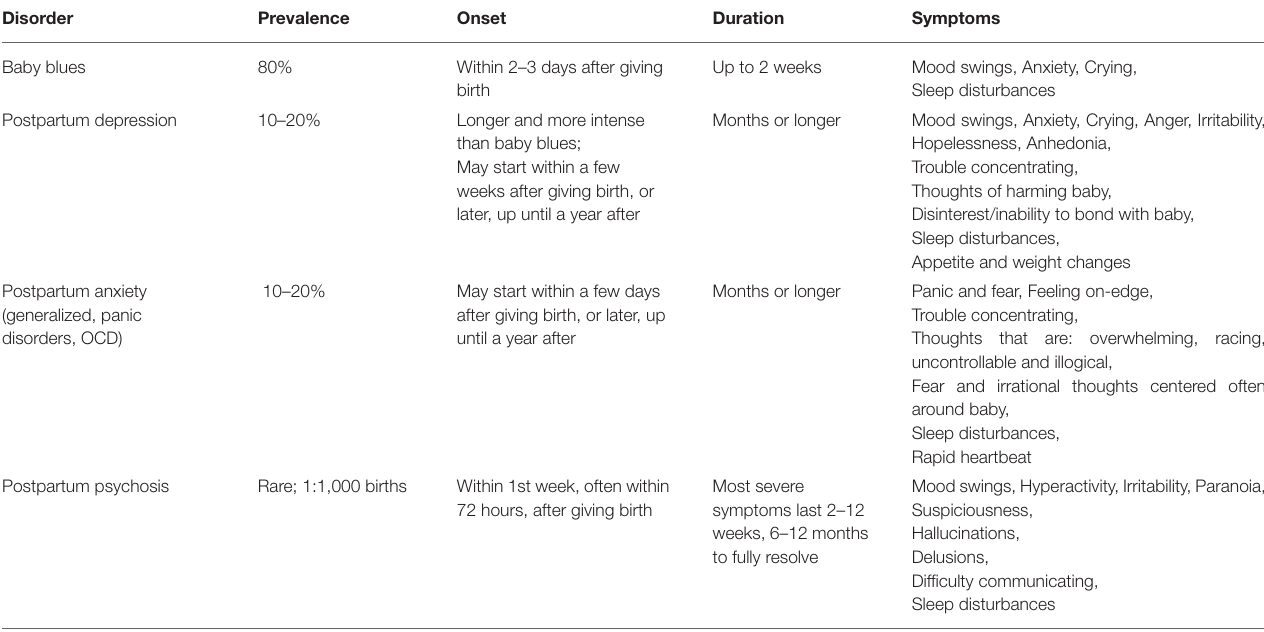
TABLE 1 | Summary of prevalence, onset, duration, and symptoms associated with postpartum mental